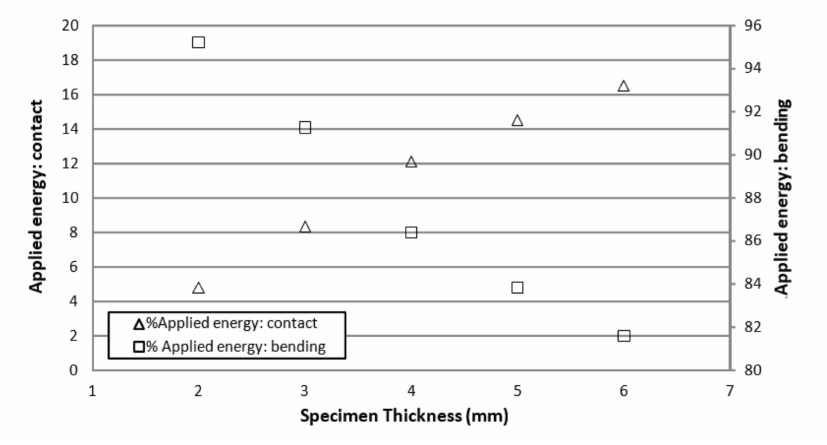
Figure 11. Applied energy percentage due to contact and bending as a function of the specimen thickness.